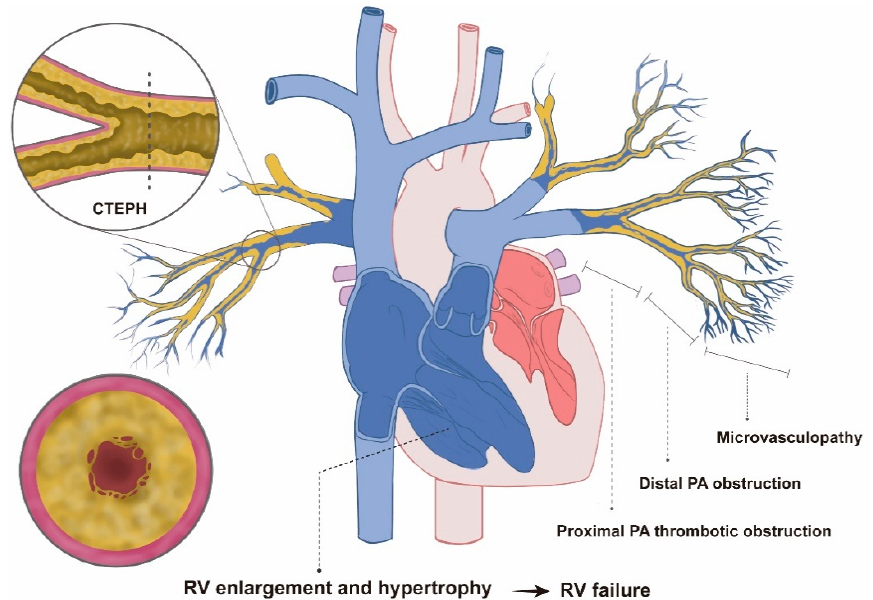
Figure 1. Pathophysiology of CTEPH. Abbreviations: CTEPH, chronic thromboembolic pulmonary hypertension; PA, pulmonary artery; RV, right ventricle.